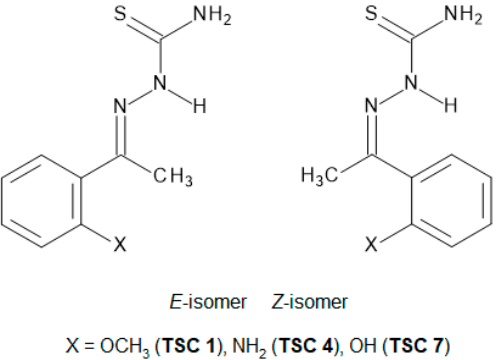
Figure 2. E- and Z- isomers of ortho -substituted thiosemicarbazones (TSC 1, 4, and 7). Figure 2. E - and Z -isomers of ortho -substituted thiosemicarbazones (TSC 1, 4, and